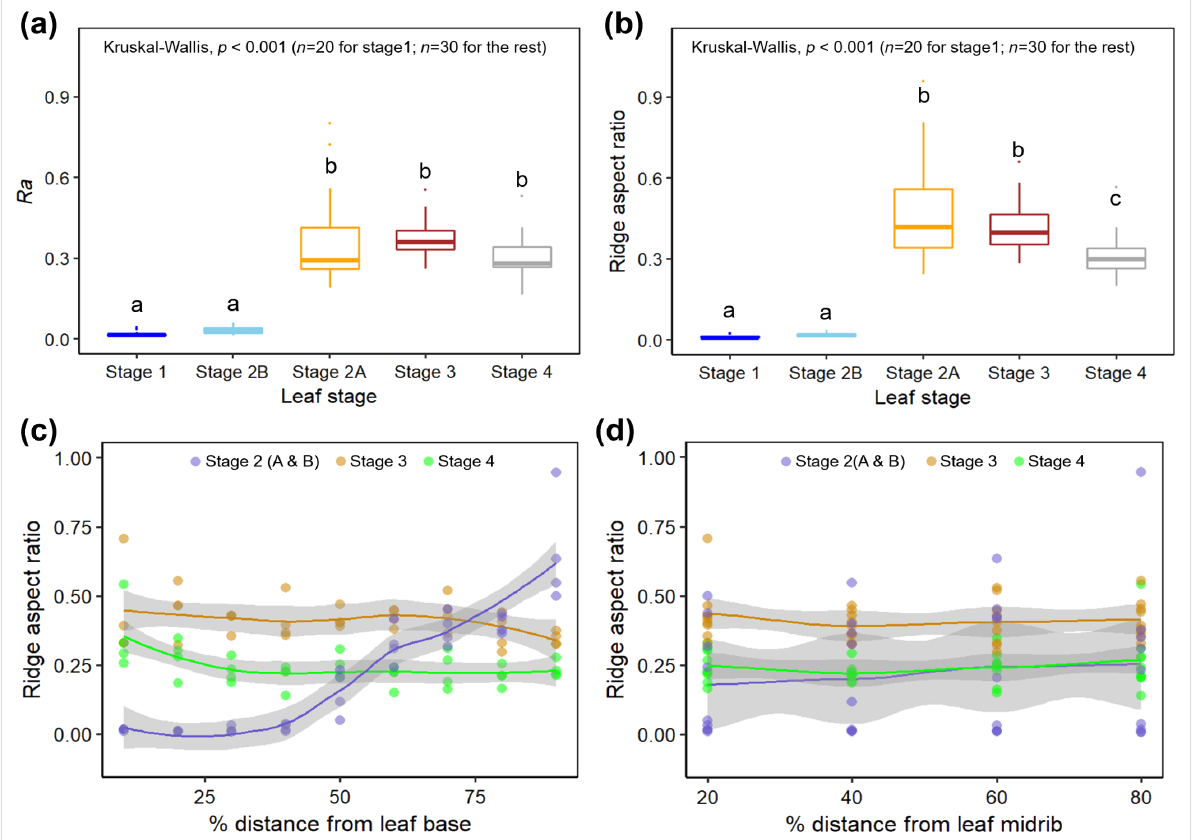
Figure 3: The plots show (a) the variation in the arithmetic average roughness ( Ra ) of the leaf surfaces with different growth stages, (b) the variation in the ridge aspect ratio with different leaf growth stages, (c) the spatial variation of the ridge aspect ratio along the direction of the midrib as percent- age distance from the base of the leaf, and (d) the variation of ridge aspect ratio perpendicular to the direction of the midrib as percentage distance from the midrib. The gray shading around the lines represents the 95% confidence interval.